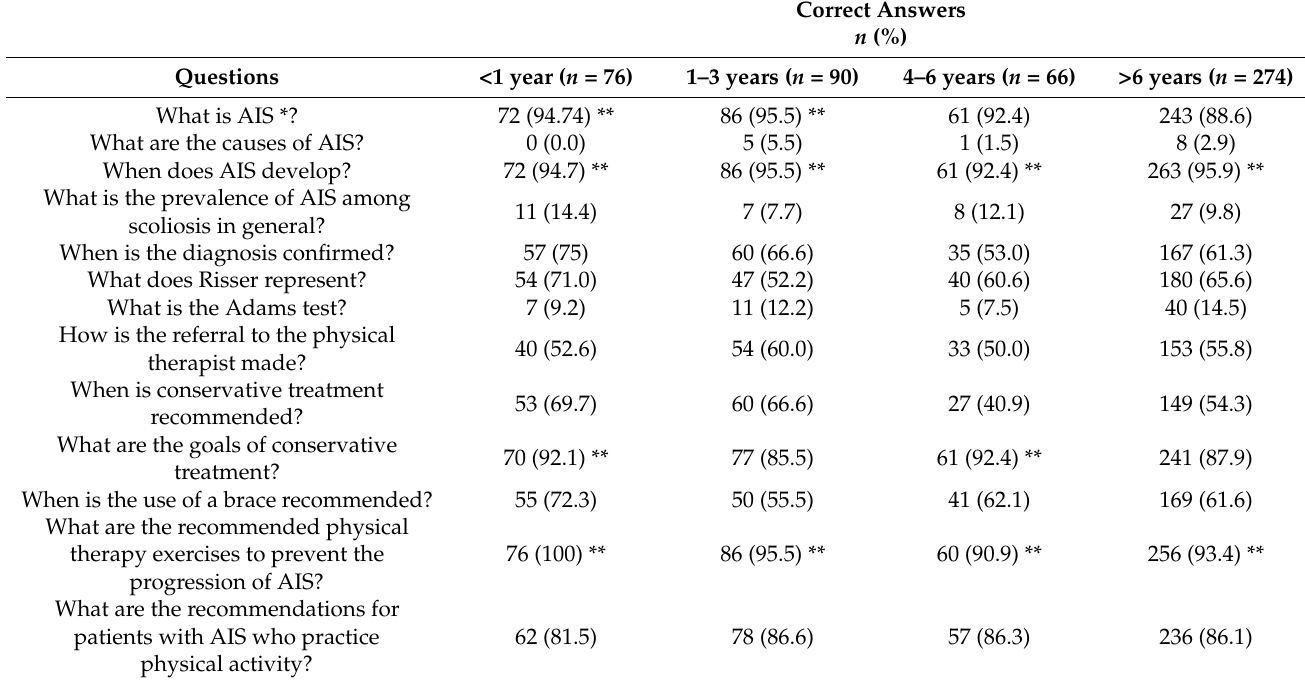
Table 2. Number of correct answers on knowledge about SOSORT according to the time since training of Brazilian physiotherapists.